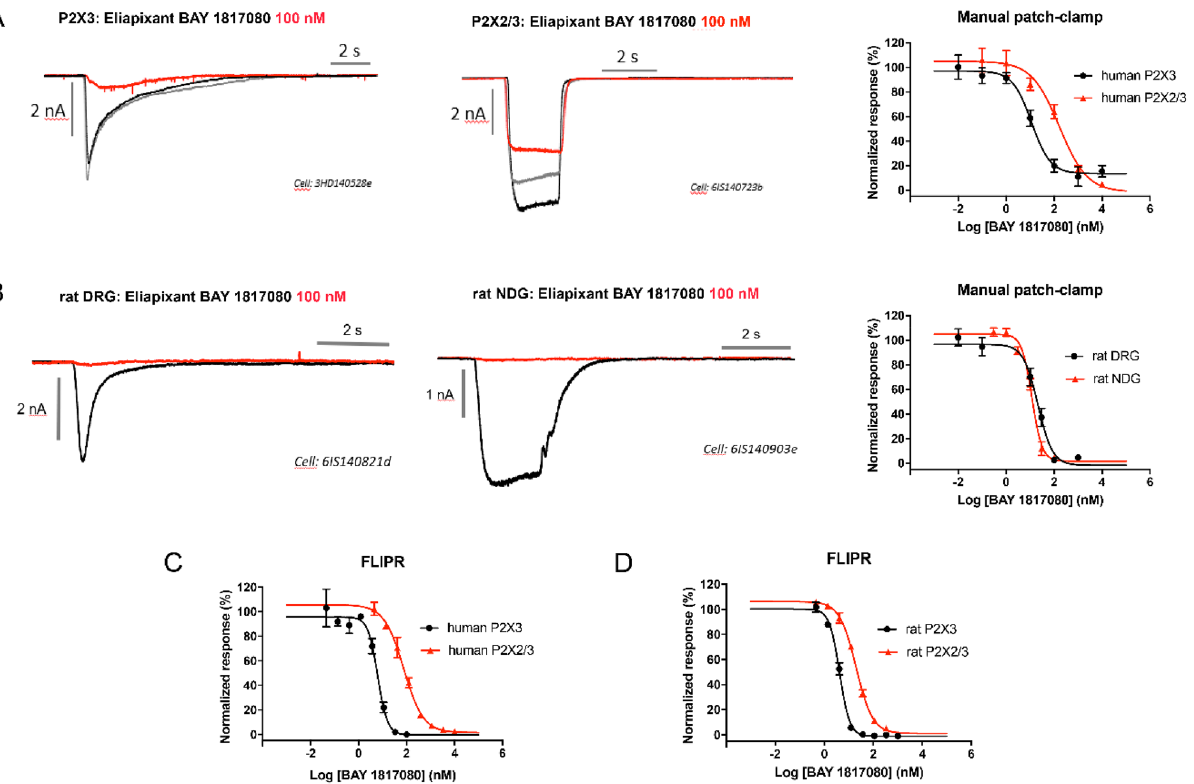
Figure 1. Eliapixant (BAY 1817080) is a potent antagonist of P2X3 in vitro. ( A ) Representative manual patch clamp traces for human P2X3 (left panel), human P2X2/3 (middle panel), and representative whole-cell patch-clamp concentration–response curves for eliapixant using recombinant cell lines expressing human P2X3 or P2X2/3. Responses to an EC 80 concentration of α,β-meATP agonist (10 µM for hP2X3 receptors and 30 μM for human P2X2/3 receptors) are shown (human P2X3, n = 3–6 cells; P2X2/3, n = 3–10 cells). Data are expressed as the mean ± SEM. ( B ) Representative manual patch clamp traces for eliapixant against native rat dorsal root ganglion (DRG, L6–L4) neurons showing predominantly P2X3-like currents (left panel), and rat nodose ganglion (NDG) currents reflecting a majority of P2X2/3 channels (middle panel), dissected from female Sprague Dawley rats. Representative whole-cell patch-clamp concentration–response curves are shown in the right panel. Responses to the α,β-meATP agonist (10 µM) were measured (DRG, n = 3–6 cells; NDG, n = 3–5 cells). Data are expressed as the mean ± SEM. ( C ) Representative concentration–response curves for eliapixant against recombinant 1321N1 cell lines expressing human P2X3 homotrimers and human P2X2/3 heterotrimers in a fluorescence imaging plate reader (FLIPR) calcium-flux assay. Responses normalized to an EC 80 concentration of the agonist, α,β-meATP, based on the increase in peak relative fluorescence units (RFU) are shown (mean ± standard error of the mean [SEM], n = 3). Representative FLIPR traces for human P2X3 and human P2X2/3 are shown in supplementary Fig. 2. ( D ) Representative concentration–response curves for eliapixant against recombinant HEK T-REx cell lines expressing rat P2X3 and rat P2X2/3 in a FLIPR calcium-flux assay (mean ± SEM, n = 3). Representative FLIPR traces for rat P2X3 and rat P2X2/3 are shown in supplementary Fig.